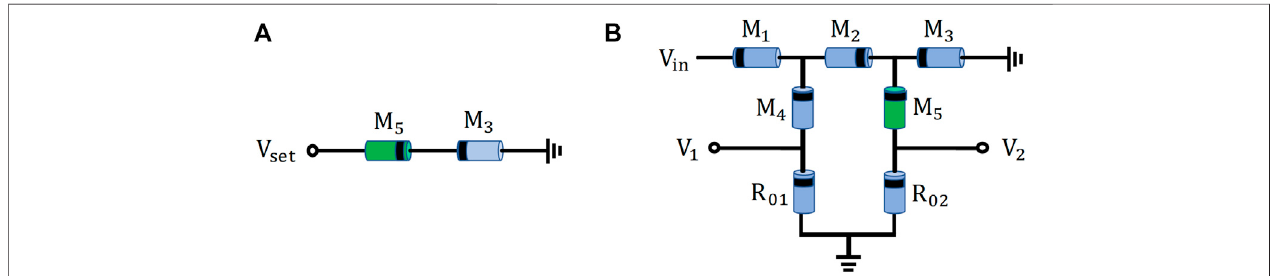
FIGURE 5 | Method of initializing the memristors. (A) Positive excitation initialization signal is input and passes only through M 5 and M 3 due to S 2 and S 3 break. Since M 5 is positively connected, the resistance is reduced until it becomes state 1. (B) After the initialization is complete, M 5 will be normally accessed into the circuit for work.